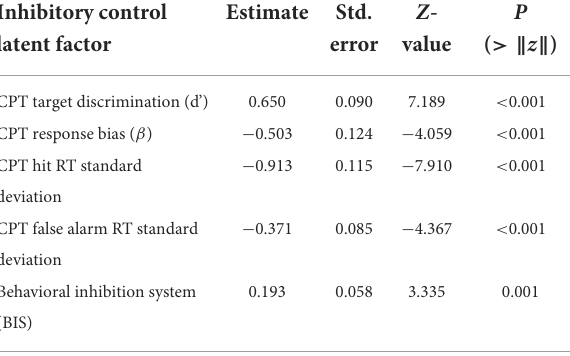
TABLE 2 Normalized estimates for latent factors estimated with structural equation modeling of inhibitory control using continuous performance task metrics and the behavioral inhibition system